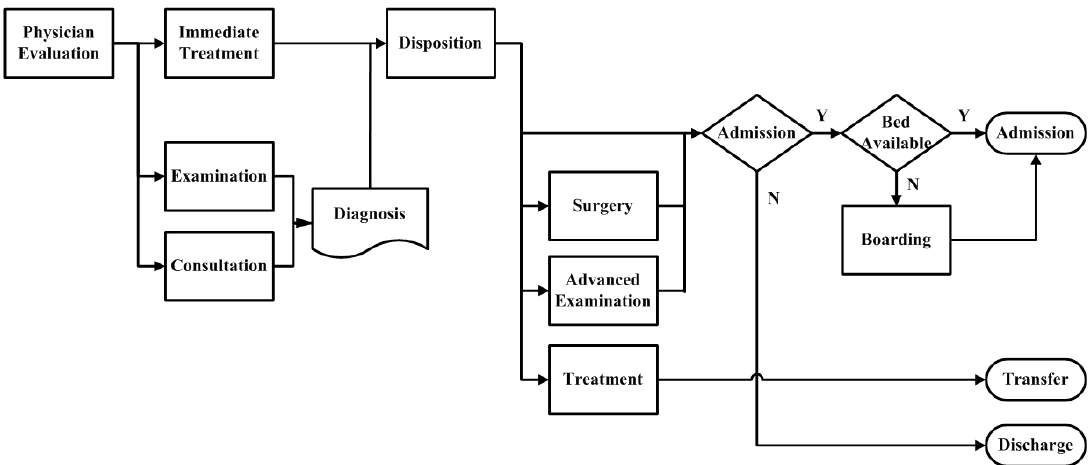
Figure 1. Emergency department operation flow chart.